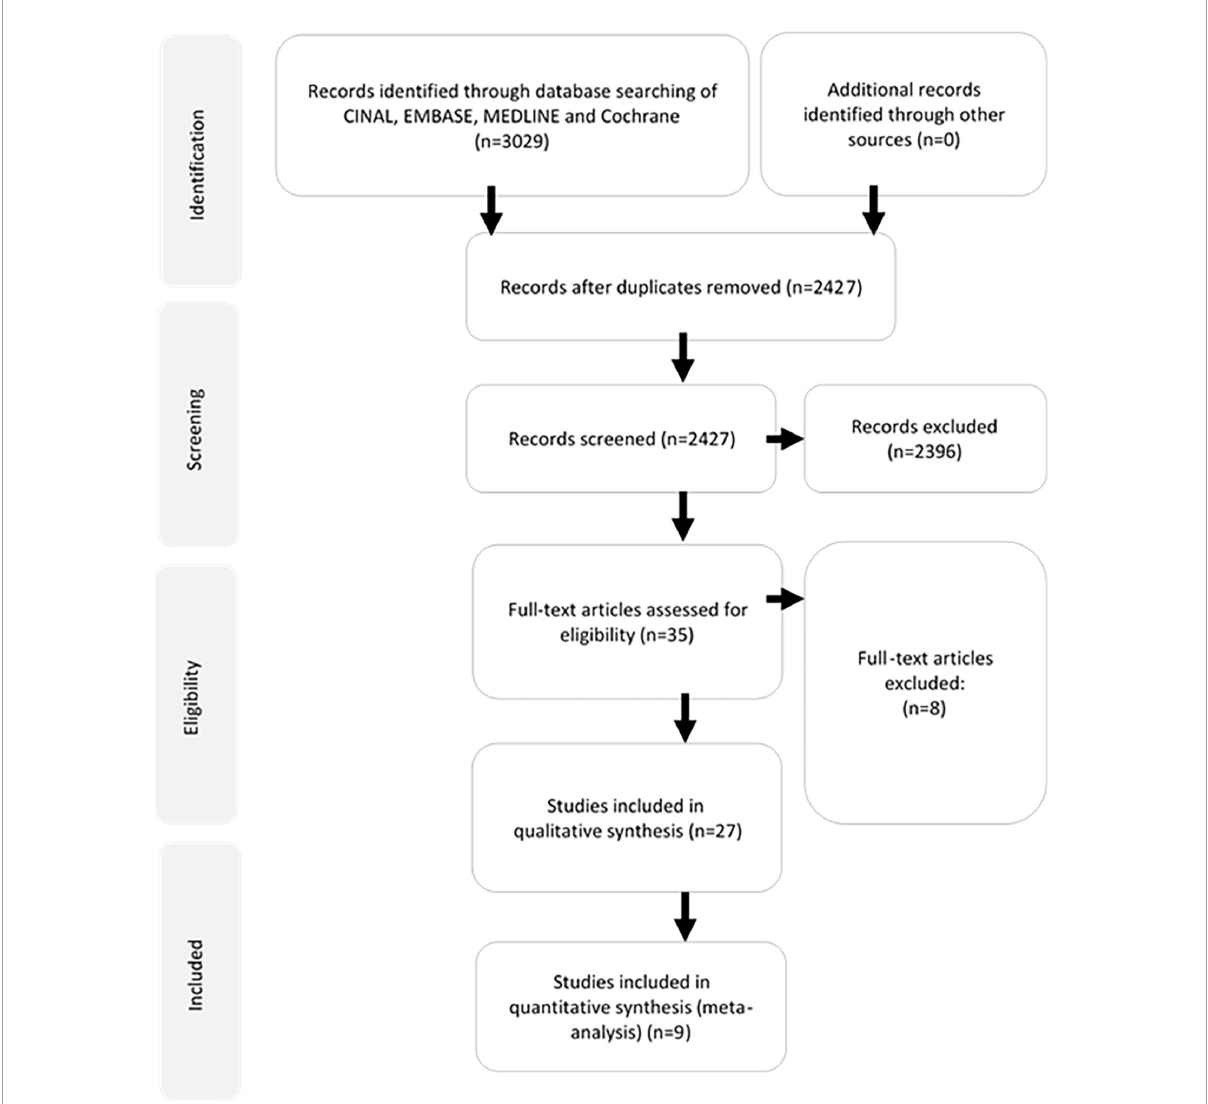
FIGURE1 PRISMA flow diagram of literature search for studies included in this